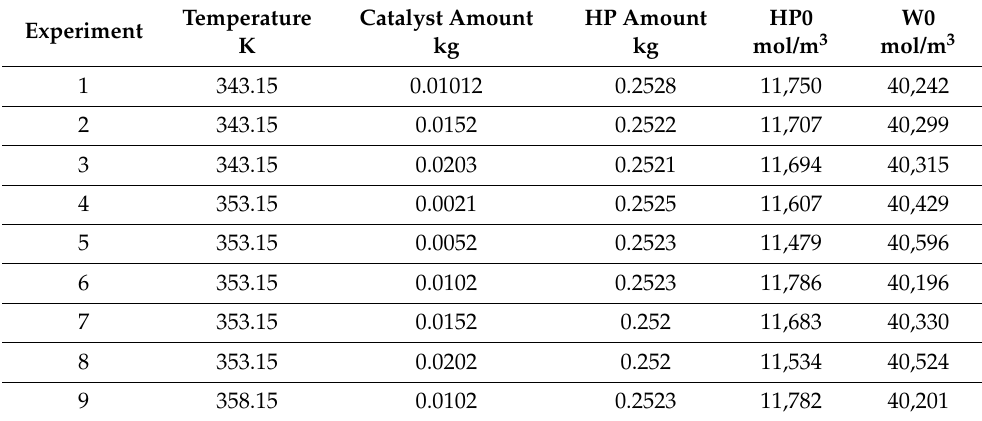
Table 1. Experimental matrix for homogeneous liquid phase system. HP: hydrogen peroxide; W: water; 0: initial conditions.